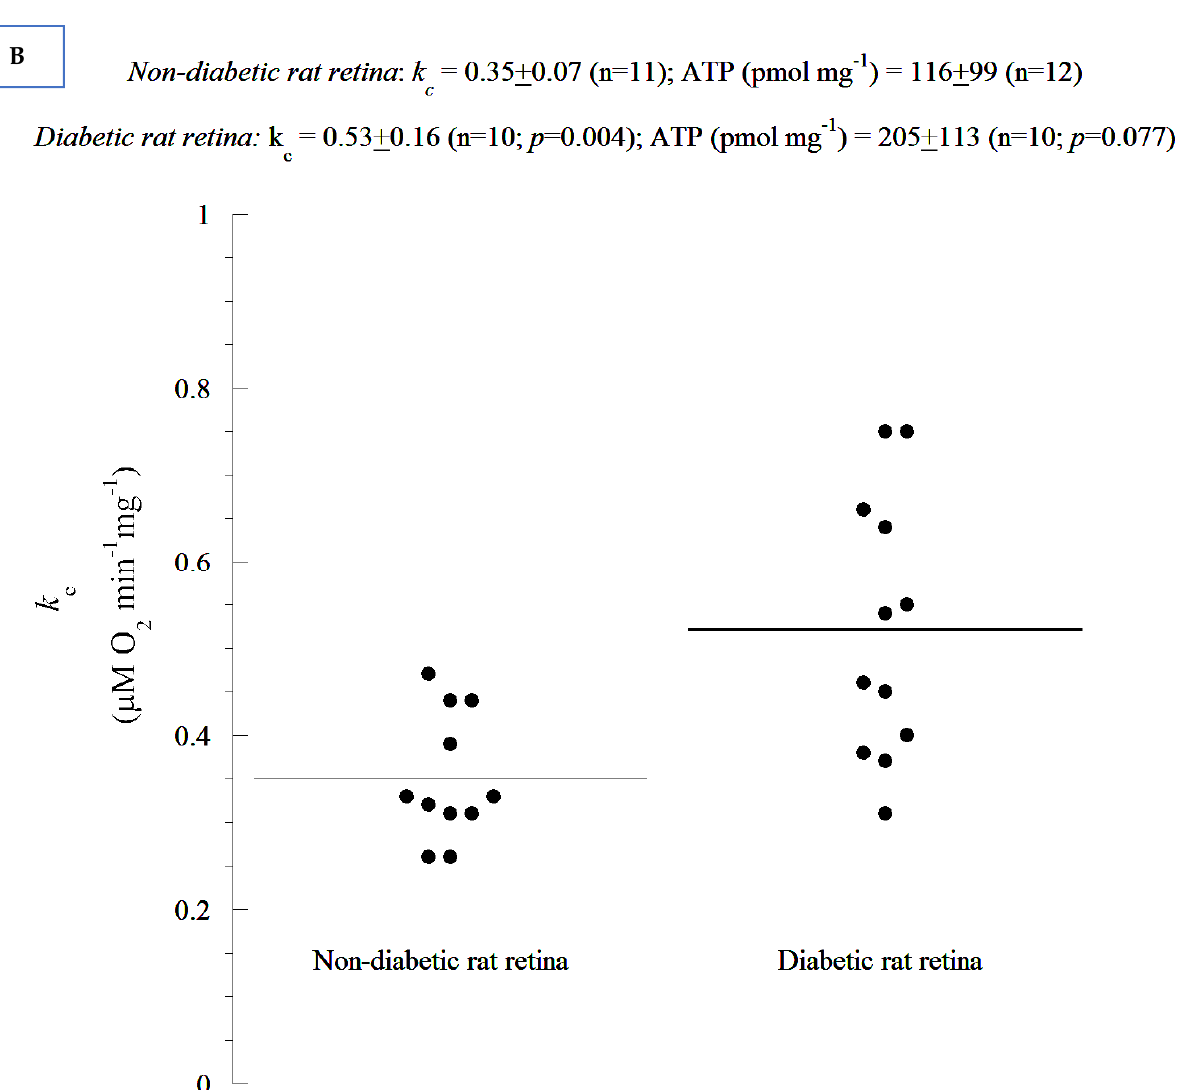
Figure 5. Representative, independent experimental runs of cellular respiration performed on individual non-diabetic and diabetic rat retinas followed by a summary of all results. ( A ) The rate of cellular respiration ( k , µ M O 2 min − 1 ) was set as the negative of the slope of [O 2 ] vs. time. The values of k c ( µ M O 2 min − 1 mg − 1 ) are shown at the bottom of each run. These runs (in PBS + 5 mM glucose) compared cellular respiration between diabetic and non-diabetic tissues. ( B ) Summary of all results, including retinal cellular ATP measurements (coupled processes). It is evident that the values of k c between the diabetic and non-diabetic tissues are overlapping.